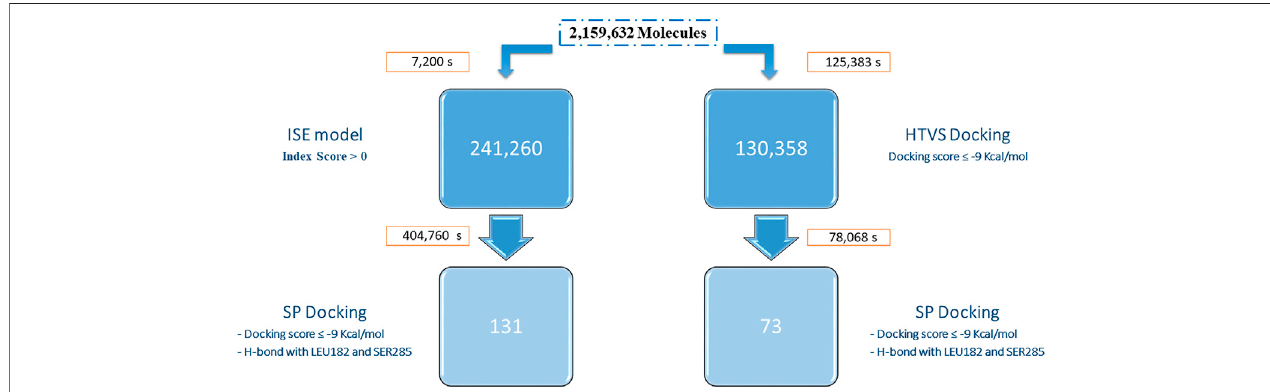
FIGURE 4 | Work fl ows of VS of the Enamine database by ISE (left) and by docking (right) . The screening times (in seconds) and the number of candidates are indicated for each step. The SP docking for the ISE hits was performed for 857,546 entries (generated by ligprep from the 241,260 candidates). The docking protocol (HTVS,ontheright)wasperformedfor5,026,503entries(generatedbyligprep).Only130,358moleculespassedthescore fi